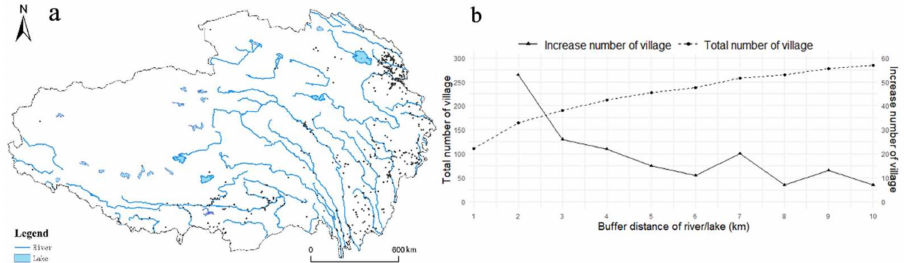
Figure 9. The relationship between river/lake and the RT villages: ( a ) spatial distribution of RT villages coupled with river network; ( b ) the change trend of the number of RT villages with buffer distance of